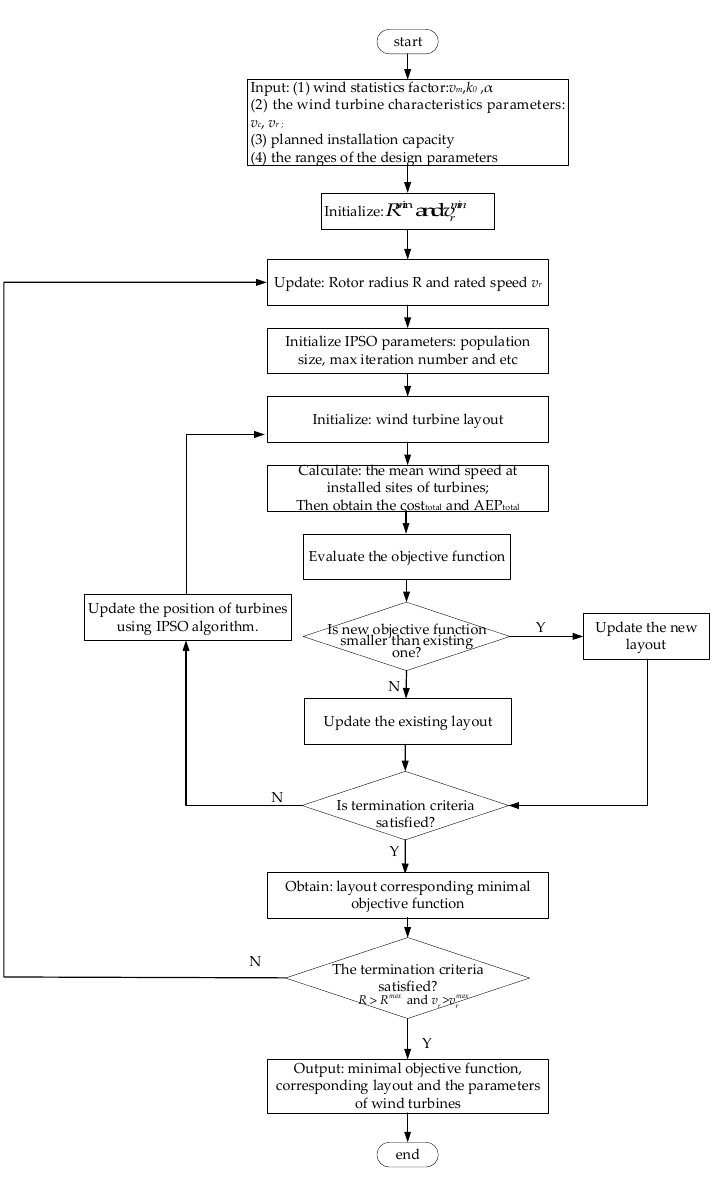
Figure 2. Flow charts of the proposed COE minimization approach.